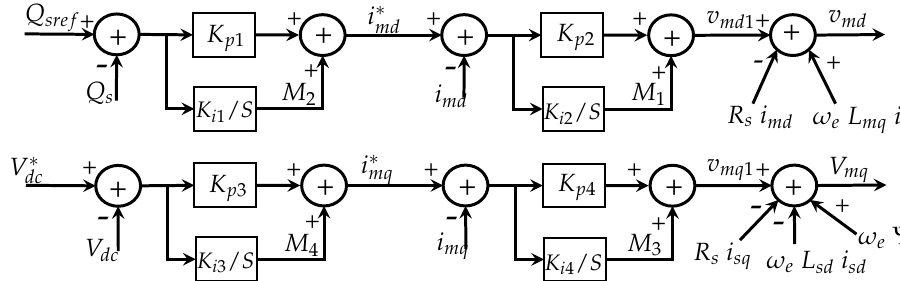
Figure 2. MSC control scheme for dc-link voltage regulation.